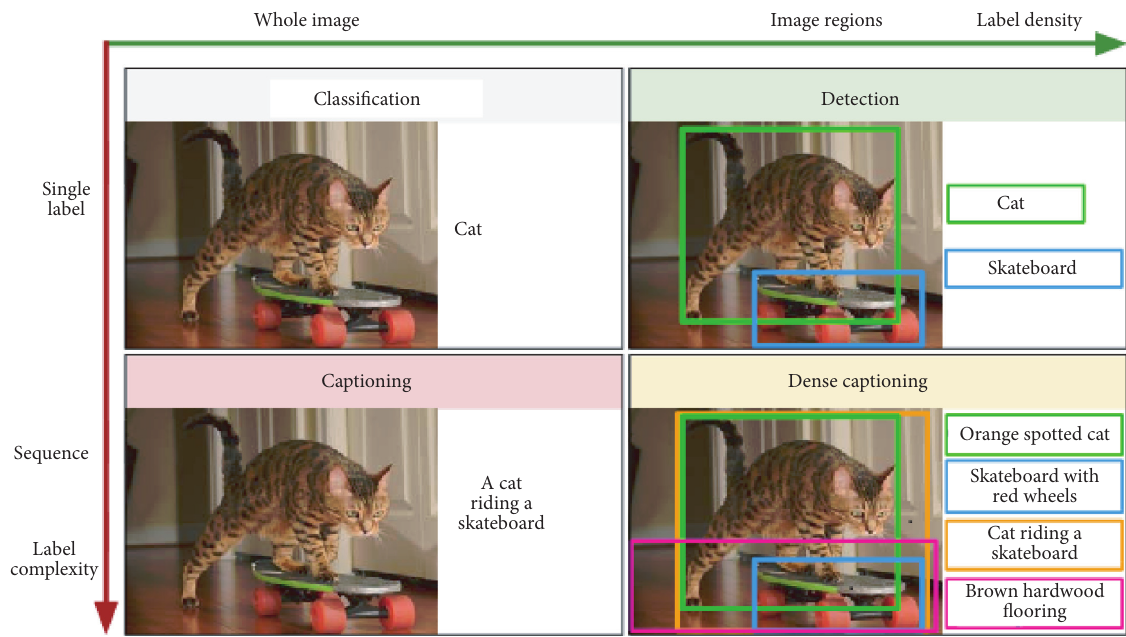
Figure 5: Dense captioning illustrating multiple annotations with a single forward pass